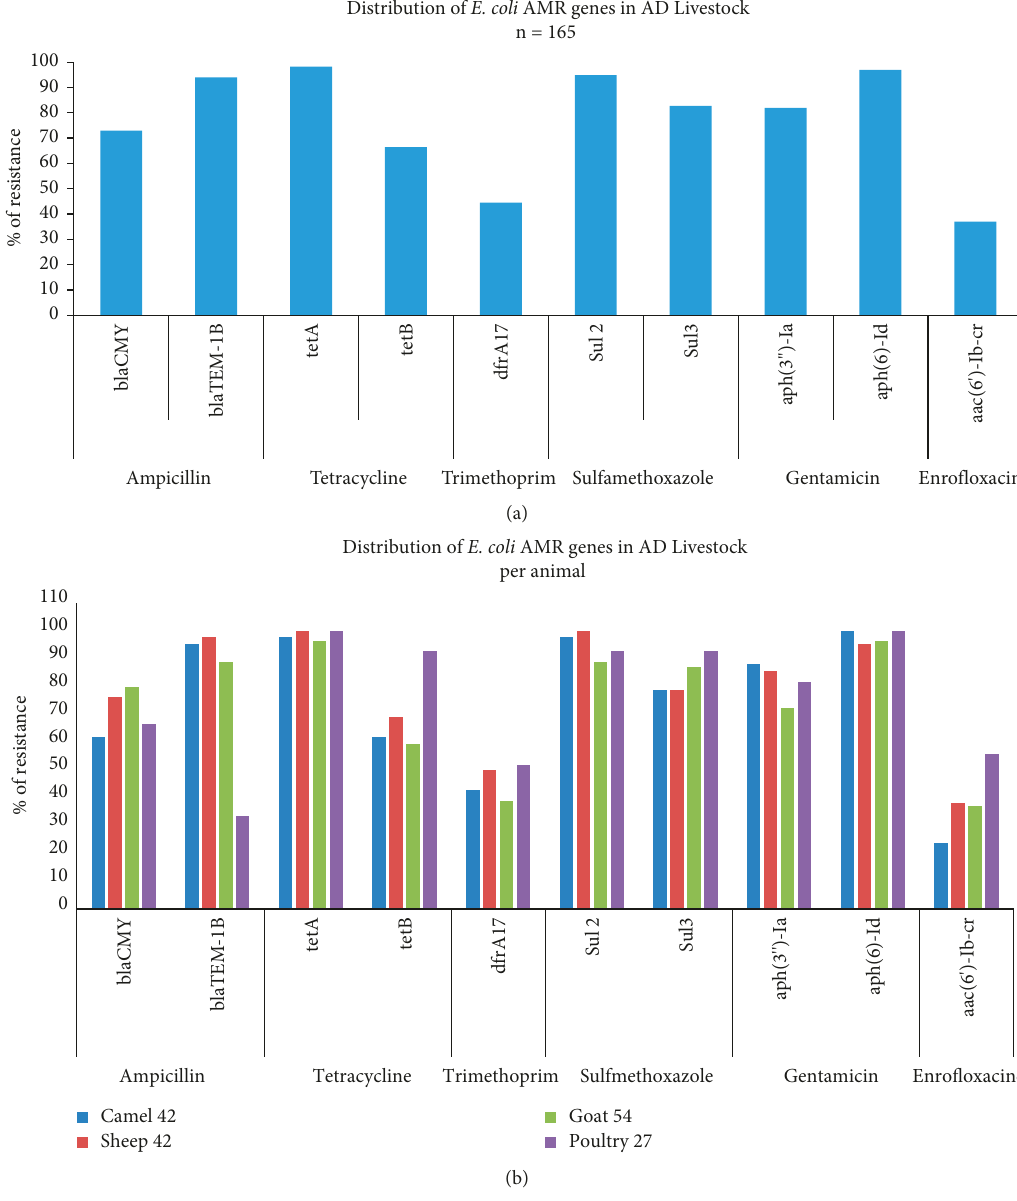
Figure 2: PCR detection of antimicrobial-resistant genes of E. coli isolated from livestock in the Emirate of Abu Dhabi. (a) Per 165 E. coli isolates and (b) per animal species (camel, sheep, goat, and poultry). Table 3: Comparison of AMR in E. coli isolates according to phenotypic and genotypic testing.